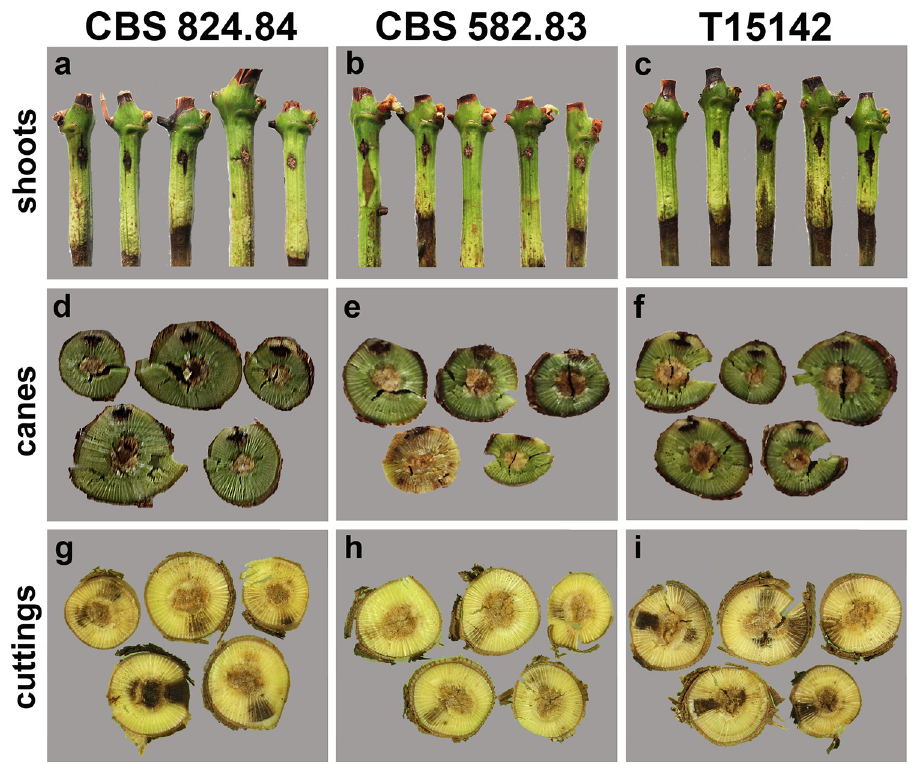
Fig 4. Artificial infection of V . vinifera cv. Cabernet Sauvignon with K . longispora isolates. ( a–c ) Shoots 21 days after inoculation with CBS 824.84 ( a ), CBS 582.83 ( b ), or T15142 ( c ) K . longispora strains. ( d–f ) Cross-sections of canes 90 days after inoculation with CBS 824.84 ( d ), CBS 582.83 ( e ), or T15142 ( f ) strains. ( g–i ) Cross-sections of cuttings 80 days after inoculation with CBS 824.84 ( g ), CBS 582.83 ( h ), or T15142 ( i ) strains.